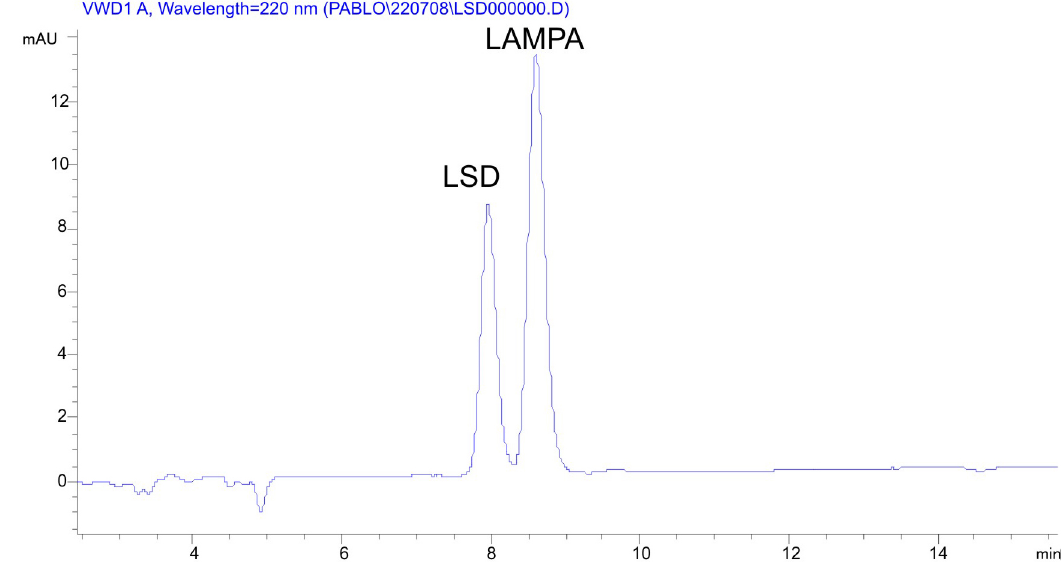
= 7.96 min) and LAMPA (t r